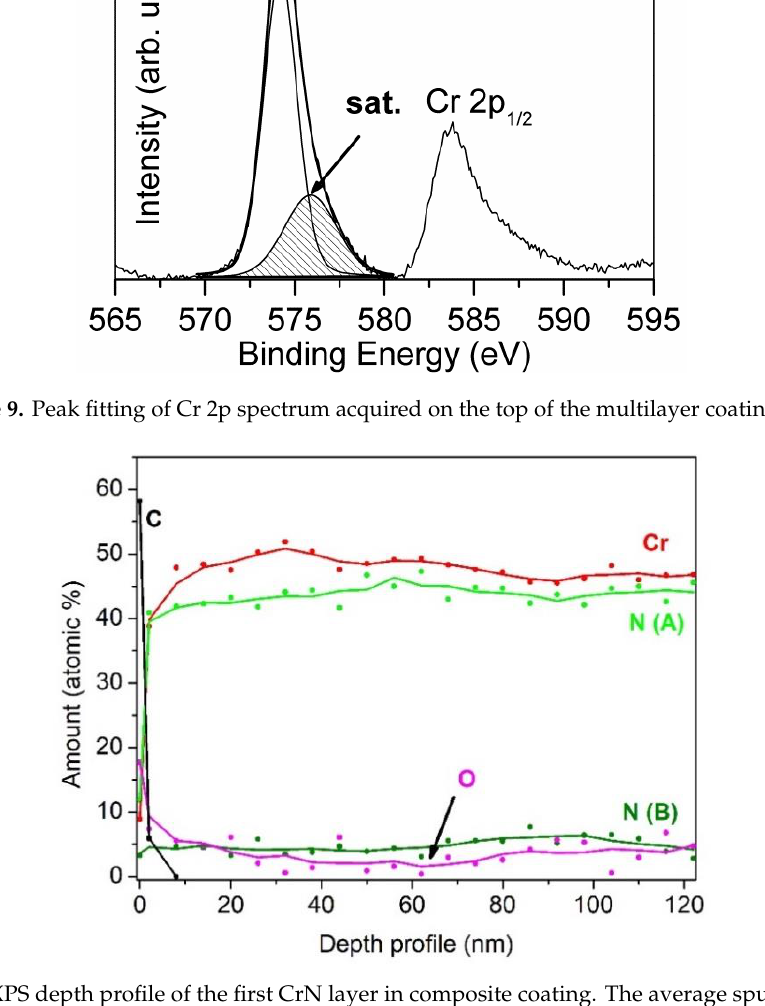
Figure 10. XPS depth profile of the first CrN layer in composite coating. The average sputtering rate was equal to 0.3 nm·min −1 [23].